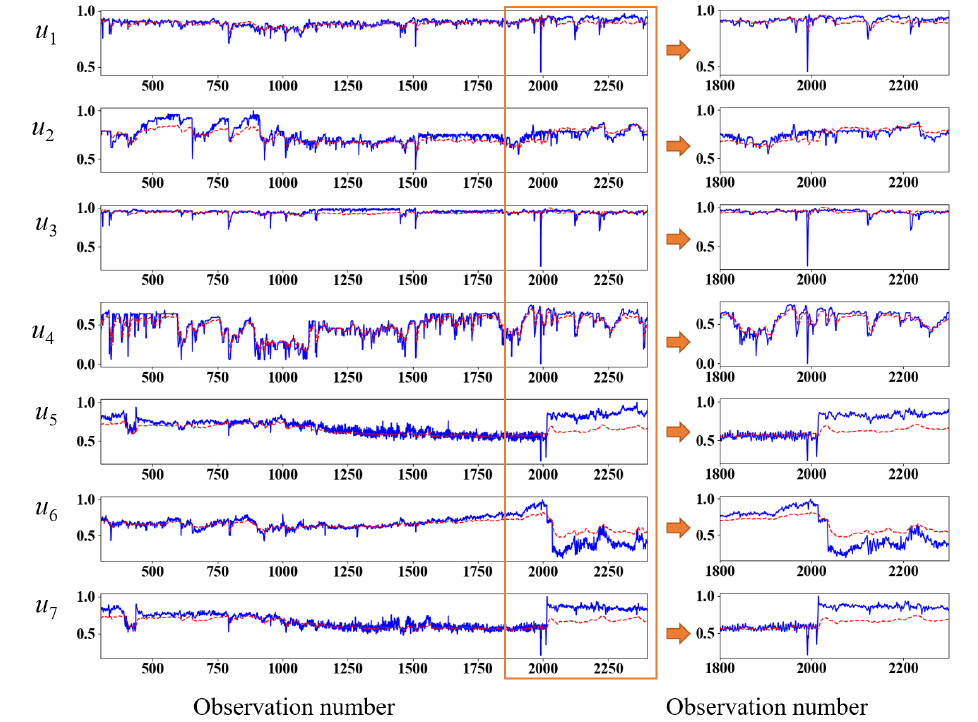
Figure 6. The prediction results of the GRU model in Case 1 (the red lines represent prediction and the blue lines represent actual